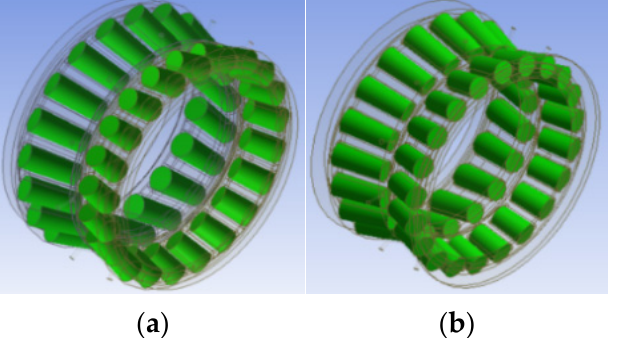
Figure 7. Internal flow field analysis models of the bearings. ( a ) Outer ring rib structure; ( b ) Inner ring rib structure.